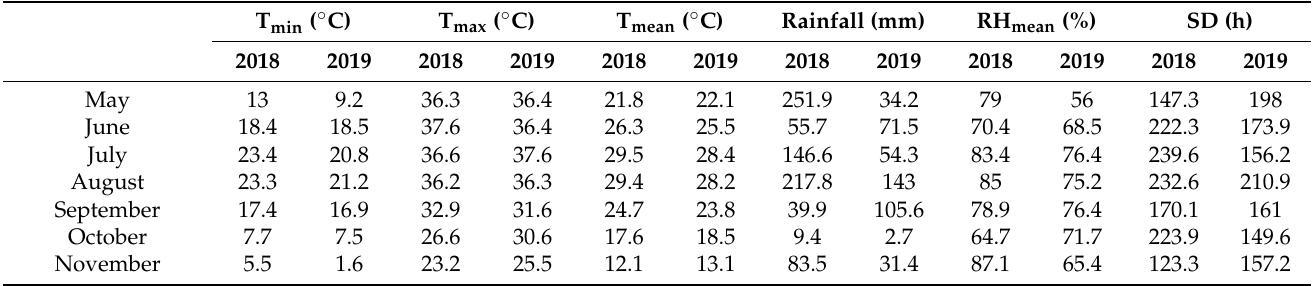
Table 1. The minimum (T min ), maximum (T max ), mean (T mean ) temperature, rainfall, mean relative humidity, and sunshine duration (SD) in the rice growing